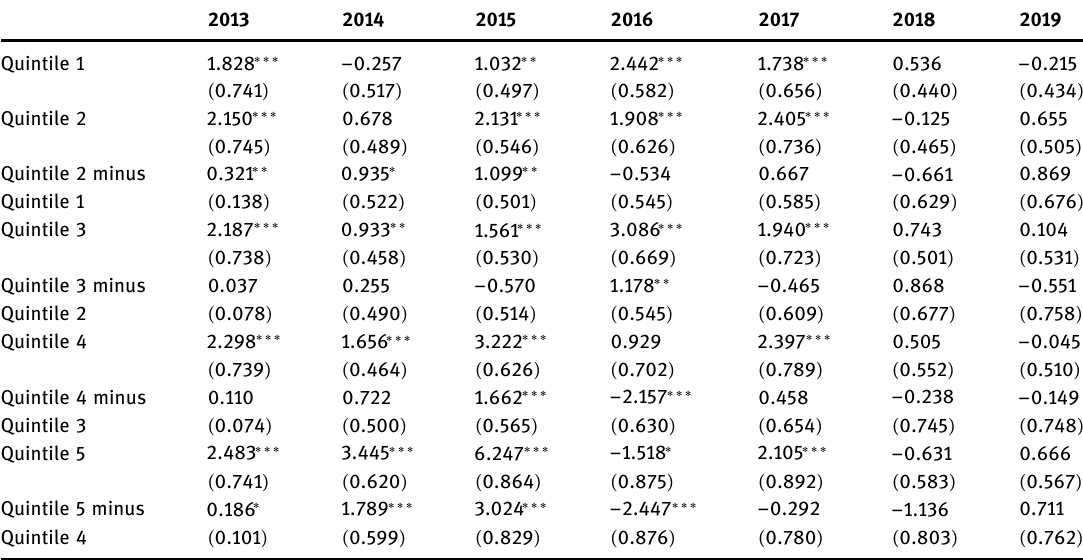
Table 5: E ff ect of pay - for - performance as ( )